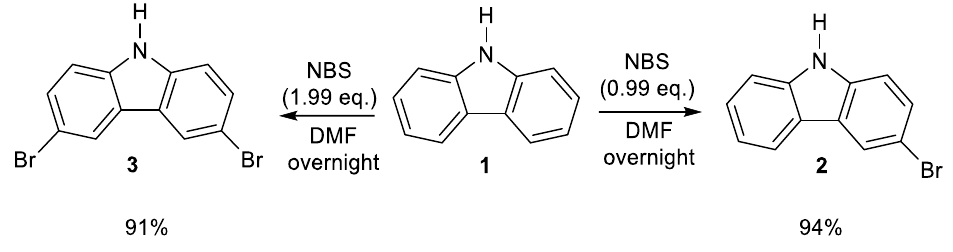
Figure 1. Molecular structures of CBP and siloxane-functionalized CBP derivatives